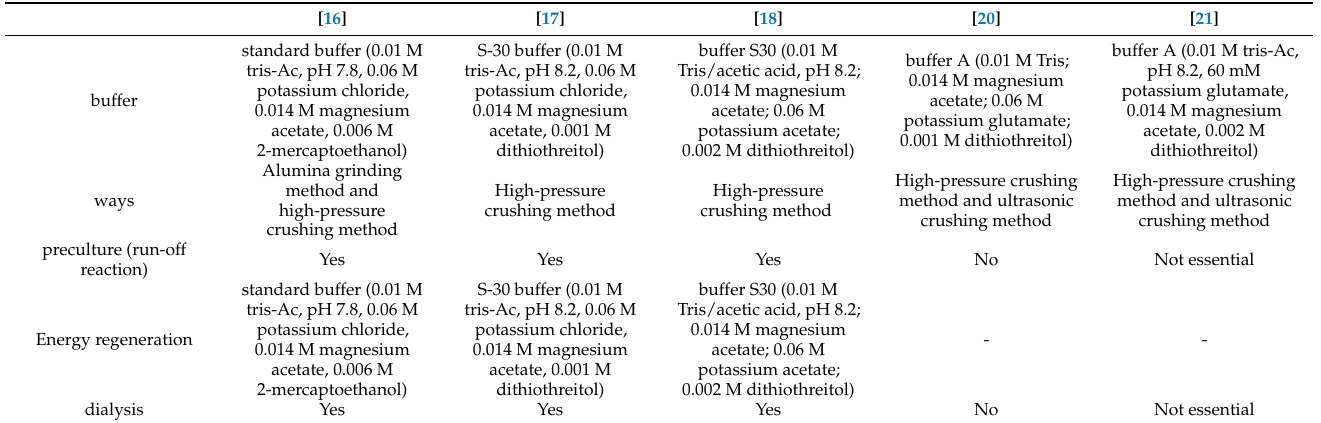
Table 1. Standard procedure for obtaining cell crude